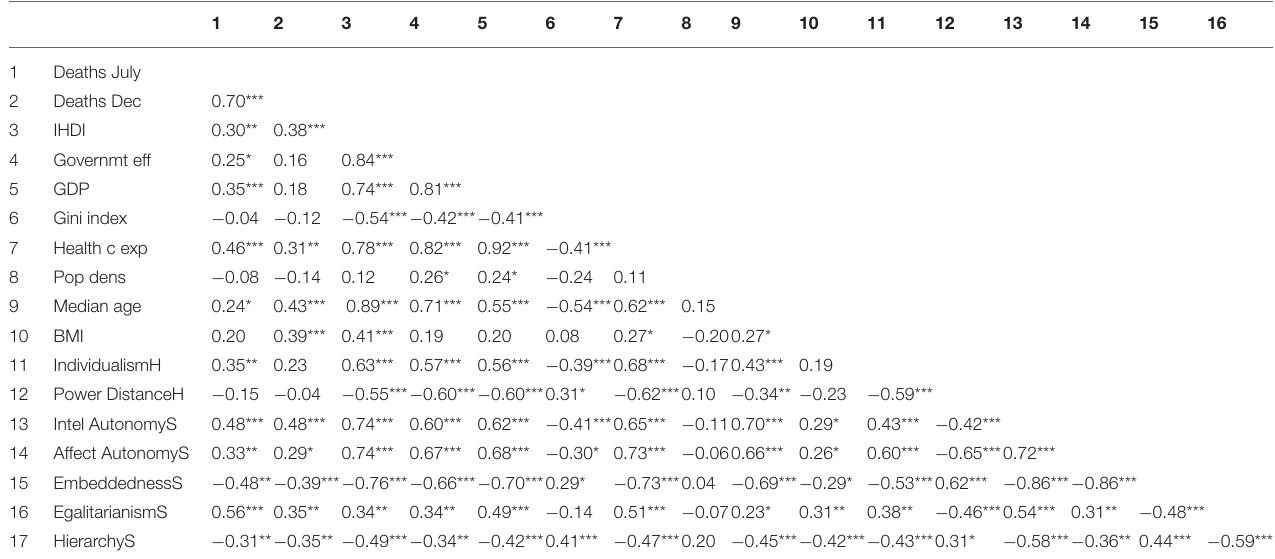
TABLE 3 | Pearson correlations of COVID-19 deaths, control variables, and cultural values.